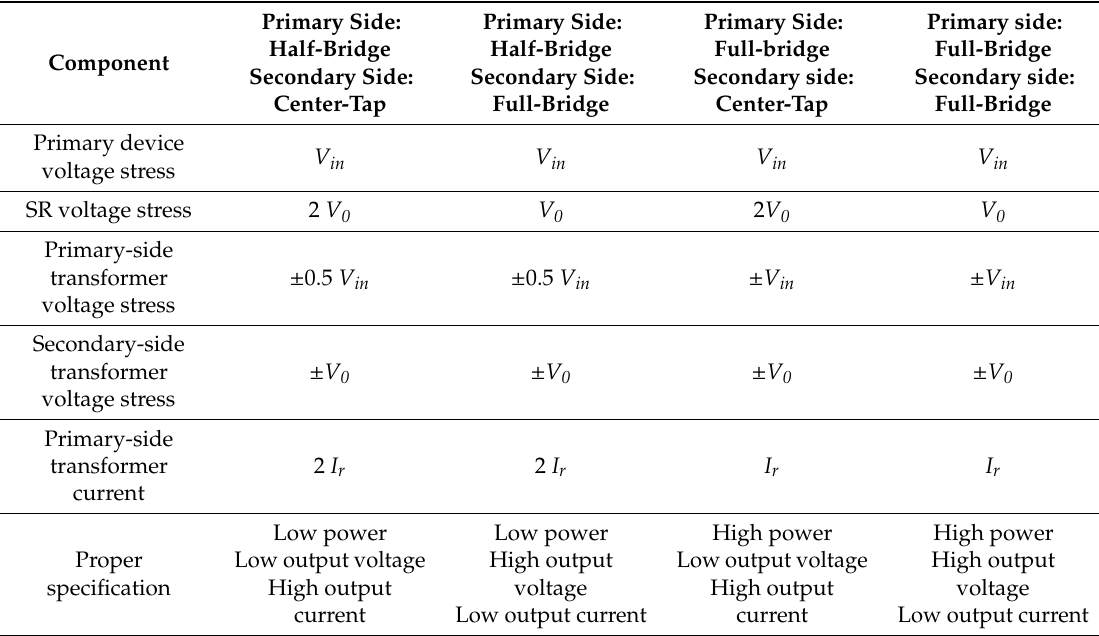
Table 3. Comparison of the four